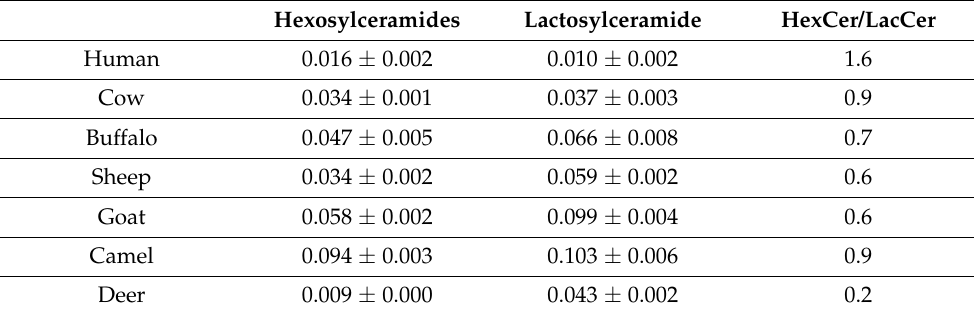
Table 3. Hexosylceramides and lactosylceramide in the samples studied (presented as averages ± standard deviations in weight % of total